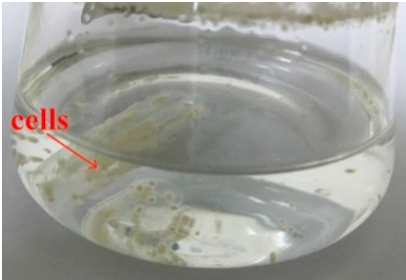
Figure 1. S. albogriseolus LBX-2 in basal medium with polyethylene (PE) membrane as the sole carbon source. The yellow cells indicated by the red arrow are S. albogriseolus LBX-2.